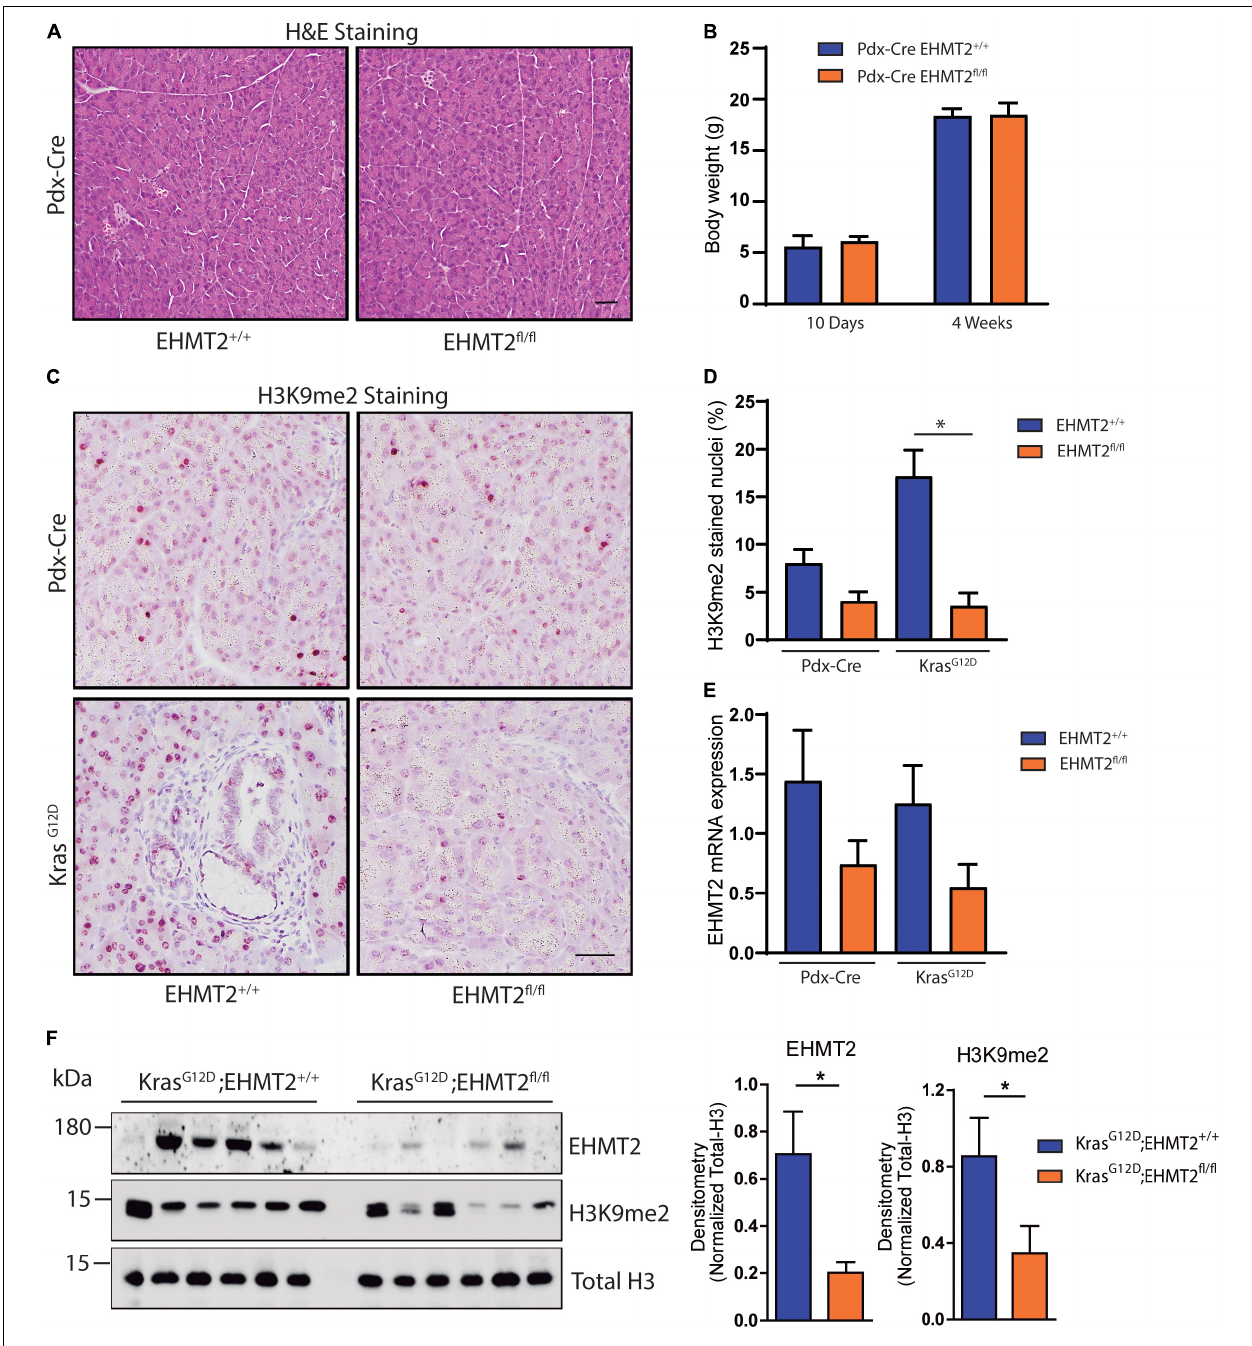
FIGURE 1 | Conditional knockout of EHMT2 driven by Pdx1-Cre does not impede normal development or architecture of the mouse pancreas. (A) Representative images from H&E stained pancreas tissues from Pdx1-Cre;EHMT2 + / + and Pdx1-Cre;EHMT2 fl / fl mice. No significant histologic or architectural changes were found. Scale = 50 µ M. (B) Graph depicts body weight from Pdx1-Cre;EHMT2 + / + and Pdx1-Cre;EHMT2 fl / fl mice at 10 days ( n = 3 Pdx1-Cre;EHMT2 + / + and n = 4 Pdx1-Cre;EHMT2 fl / fl ) and 4 weeks ( n = 16 Pdx1-Cre;EHMT2 + / + and n = 7 Pdx1-Cre;EHMT2 fl / fl ) of age. (C) Representative images of H3K9me2 IHC on pancreatic tissues from Pdx1-Cre and Pdx1-Cre;LSL-Kras G 12 D mice with WT EHMT2 alleles ( EHMT2 + / + ) or crossed to homozygous floxed EHMT2 ( EHMT2 fl / fl ) animals. Scale = 50 µ M. (D) Percentage of nuclei positive for H3K9me2 was quantified from a minimum of 5 random fields at 10 × magnification ( n = 3/group). (E) Levels of EHMT2 transcript were measured by RT-PCR on RNA isolated from whole pancreas of Pdx1-Cre;EHMT2 + / + and Pdx1-Cre;EHMT2 fl / fl mice, as well as after crossing to LSL-Kras G 12 D animals ( n = 8/group). The EHMT2 levels were normalized to GAPDH, B2M and β -actin transcripts. (F) Protein lysates from whole pancreas of Pdx1-Cre;LSL-Kras G 12 D and Pdx1-Cre;LSL-Kras G 12 D ;EHMT2 fl / fl mice were evaluated. Left: Western blots were probed with antibodies against EHMT2 and H3K9me2. Total H3 was used as loading control. Right: Graph depicts relative densitometry values for EHMT2 and H3K9me2 levels normalized to total H3 ( n = 6/group). * indicates p -value ≤ 0.05. All data is expressed as mean ± SEM.